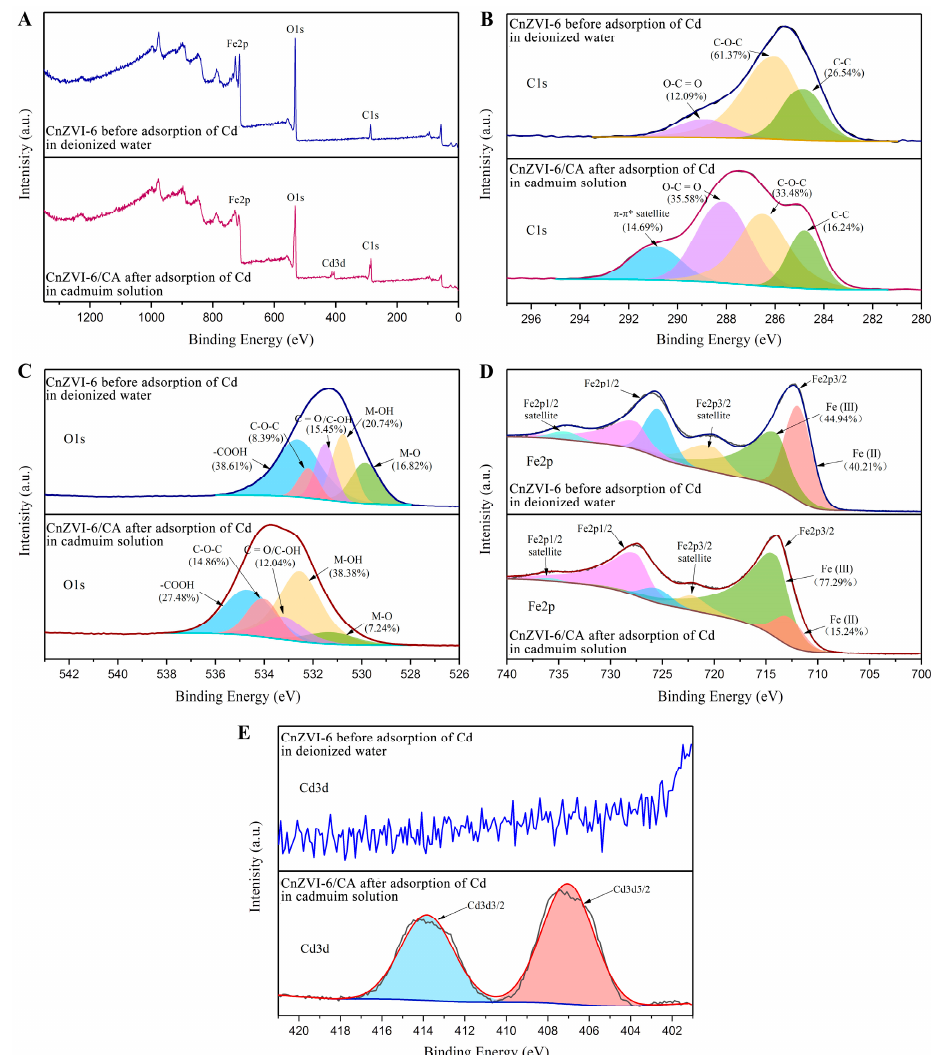
Figure 4. XPS spectra of CnZVI-6 before the adsorption of Cd in deionized water (blue) and CnZVI-6/CA after adsorption of Cd in cadmium solution (red): ( A ) full survey of XPS spectra; ( B ) C 1s; ( C ) O 1s; ( D ) Fe 2p; and ( E ) Cd 3d.